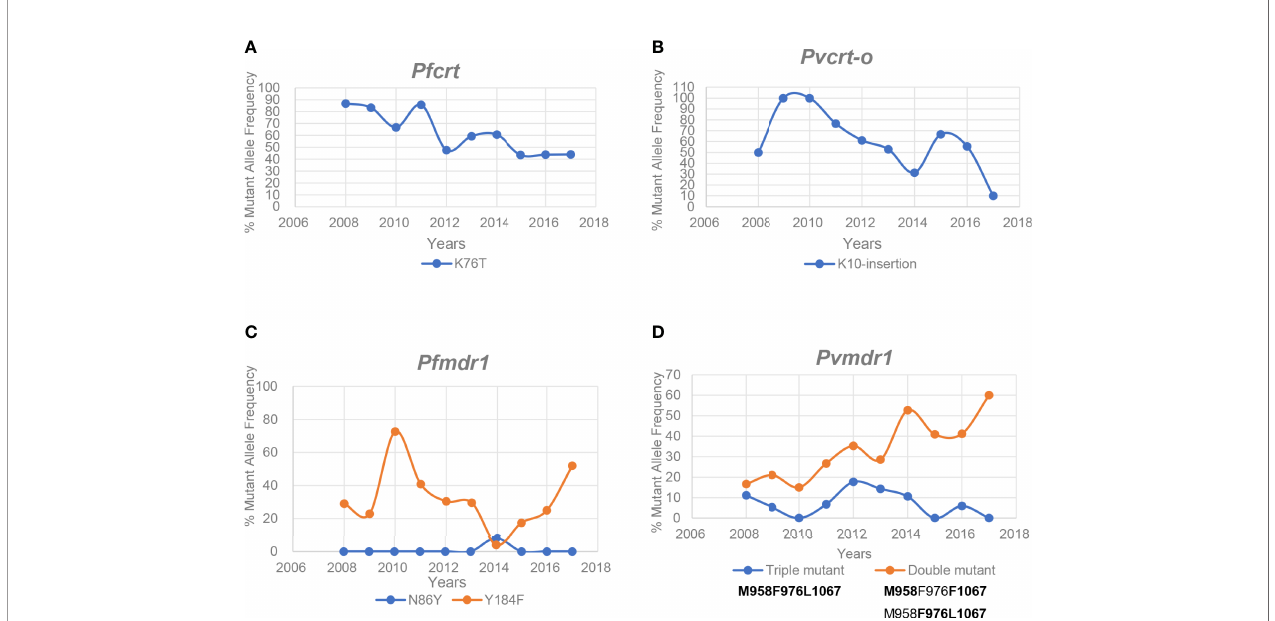
FIGURE 3 | Genotype frequency variation of pfcrt , pvcrt-o , pfmdr1 , and pvmdr1 . (A, B) Mutant locus frequency of K76T in pfcrt and K10 insertion in pvcrt-o . (C) Mutant locus frequency of N86Y in pfmdr1 is given in blue and red, respectively. (D) Mutant locus frequency of triple mutant and double mutant in pvmdr1 is given in blue and red,